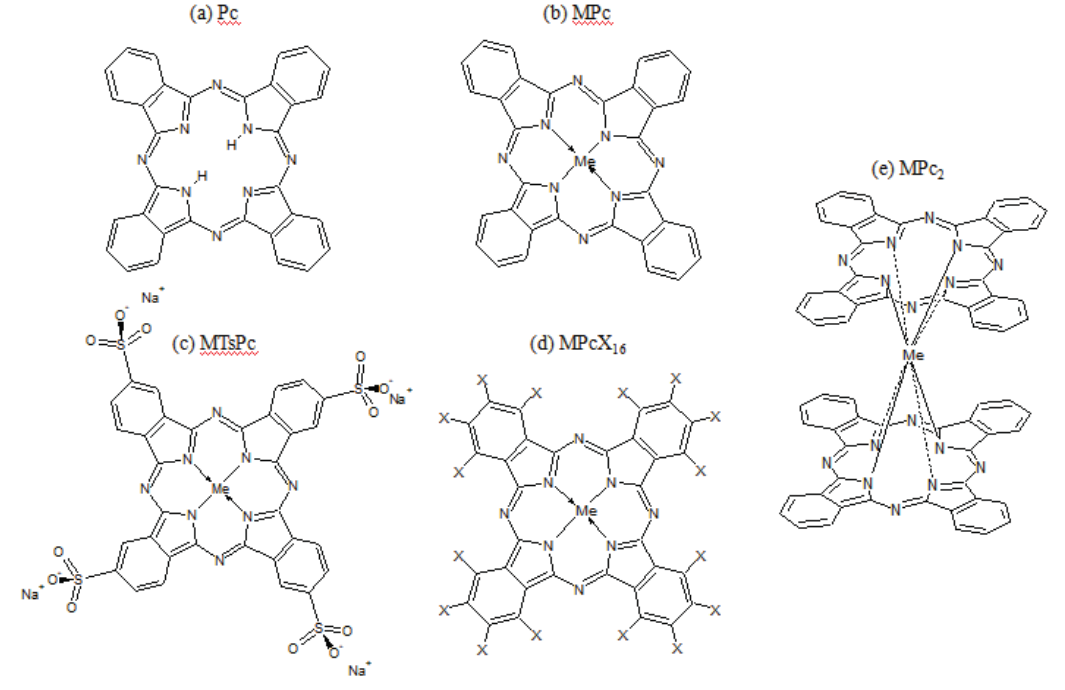
Figure 1 - Chemical structure of ( a ) phthalocyanine (Pc), ( b ) metallophthalocyanine (MPc), ( c ) phthalocyanine with side groups (SO 3- ) attached its structure (MTsPc), ( d ) phthalocyanine with halogen substitution (MPcX F), and ( e ) double-decker phthalocyanine (MPc